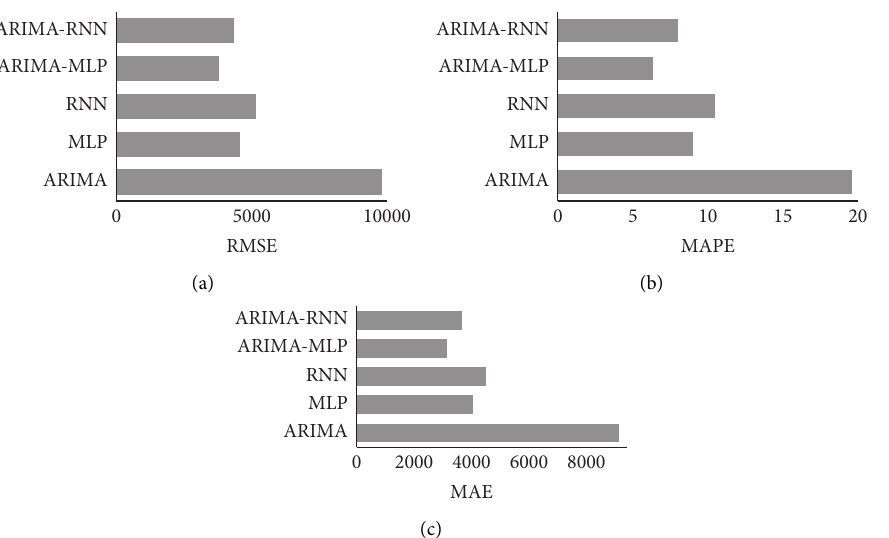
Figure 1: Forecast comparison across different models for Pakistan.